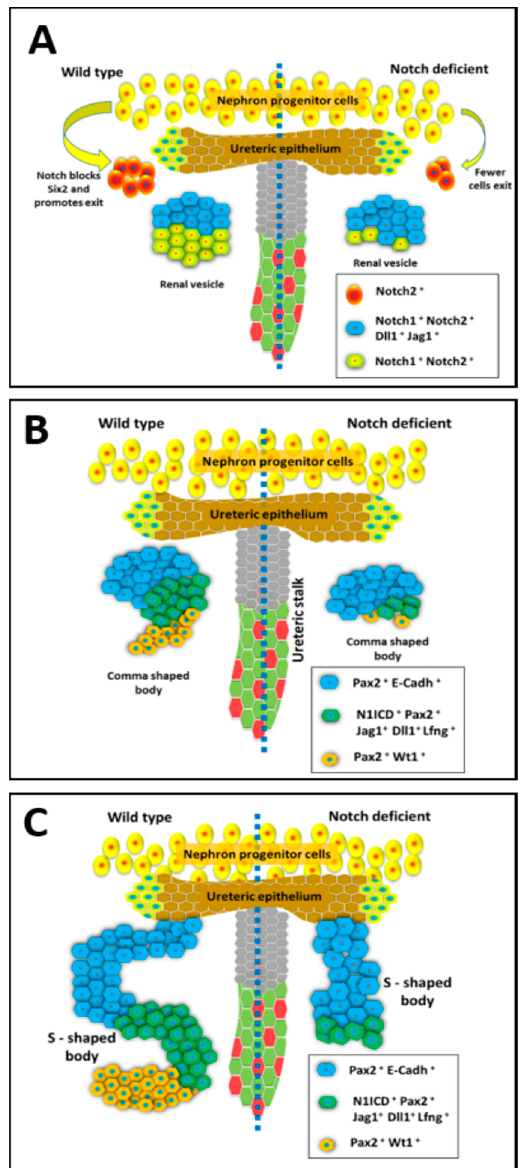
Figure 1. The expression and function of Notch during the early stages of Nephrogenesis. The different stages of mammalian renal nephron development with normal development (on left side) compared to kidney development under deficient Notch signaling conditions (on right side). ( A ) The nephron progenitor state is maintained through Six2 expression which is normally repressed by Notch signaling to allow cells to begin differentiation within pre-tubular aggregates that become renal vesicles (RV). The RV have distinct segments with Notch ligands having a restricted expression in the distal compartment close to the ureteric bud UB tip. Notch deficiency within the nephron progenitors results in abnormal patterning of the RV. ( B ) Diagram of the developing nephron at the comma shaped stage. The renal vesicle undergoes further morphological changes from spherical body to comma shaped body. Notch deficiency results in decreased proliferation of Pax2+; Jag1+ cells. ( C ) Diagram of the developing nephron at the S-shaped stage, which occurs after the comma-shaped